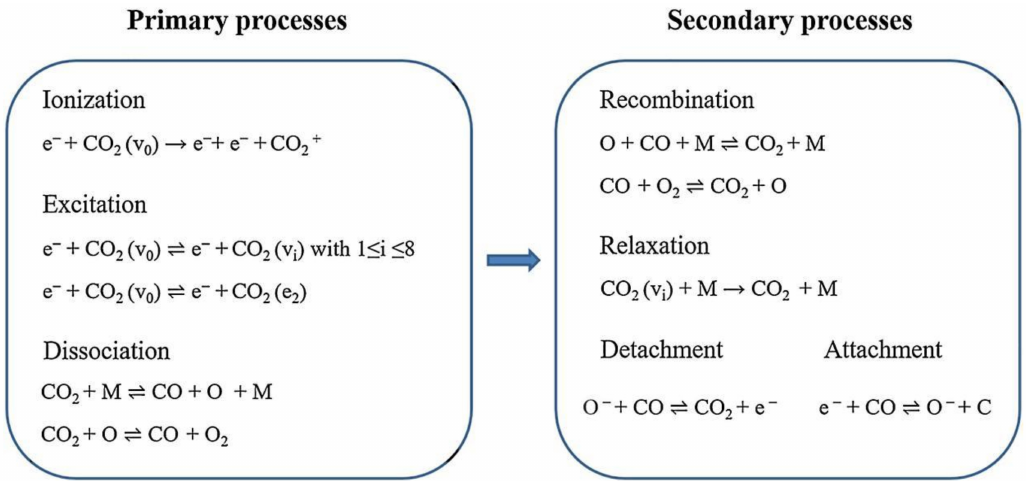
Figure 7. Basic process of CO 2 decomposition in low-temperature plasma (M = CO 2 , CO or O 2 ). Adapted and reprinted with permissions from [59], Copyright 2018,